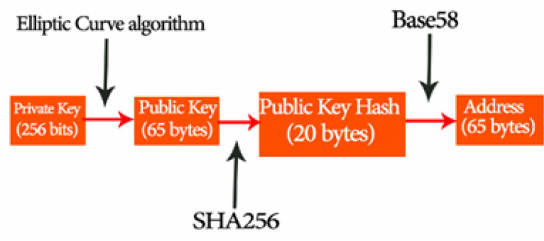
Figure 3. Blockchain asymmetric encryption